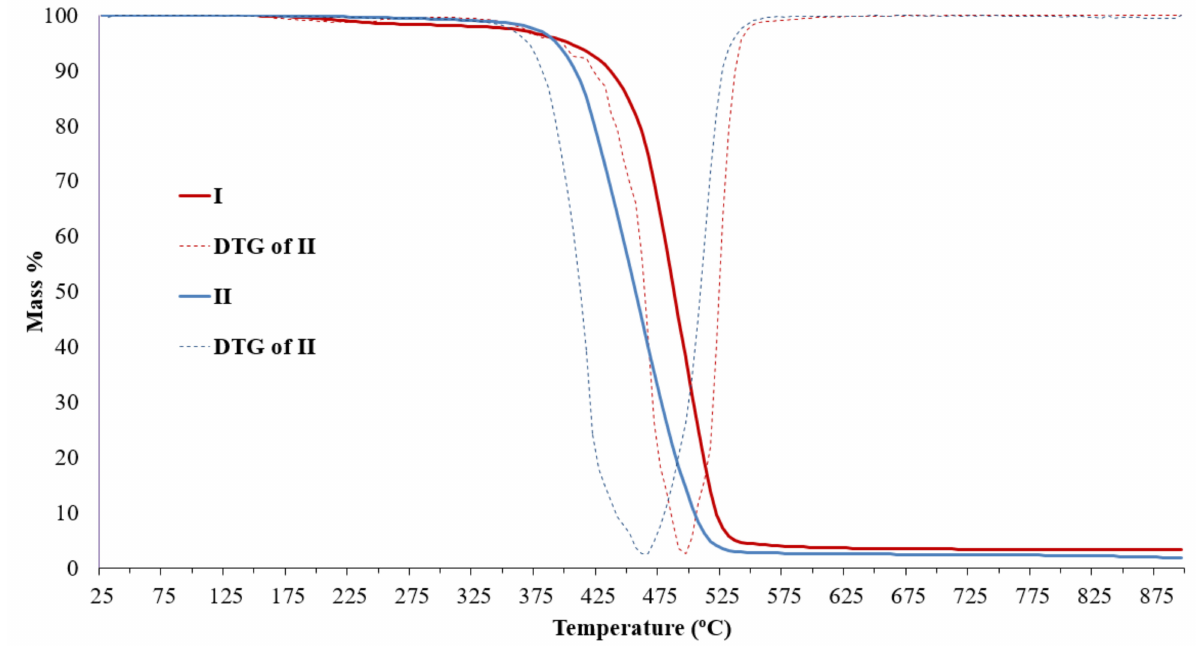
Figure 9. TG data of IV (I)-V (II)